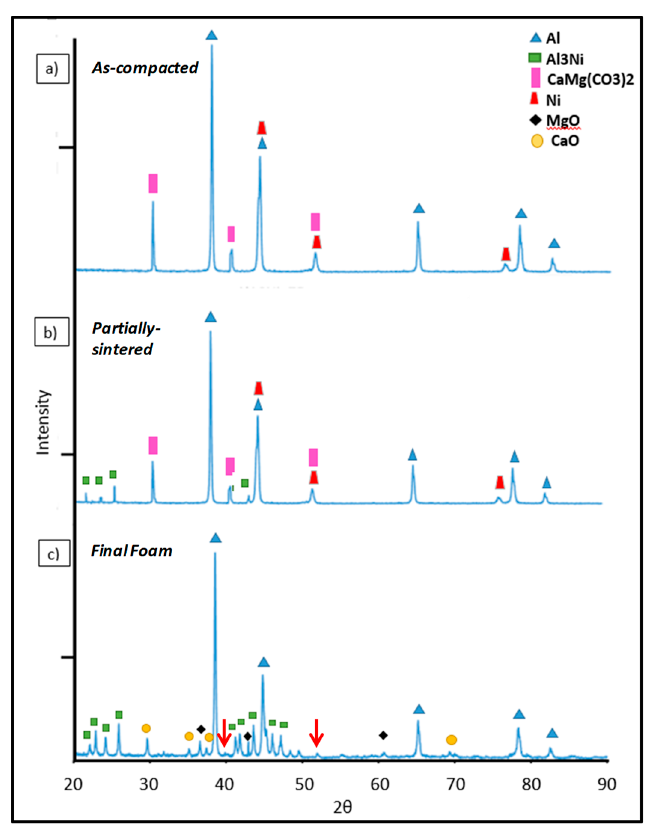
Figure 11. Phase identification in the as-compacted ( a ), partially sintered ( b ), and final foam ( c ) containing Al–10Ni with 7 wt.% dolomite.